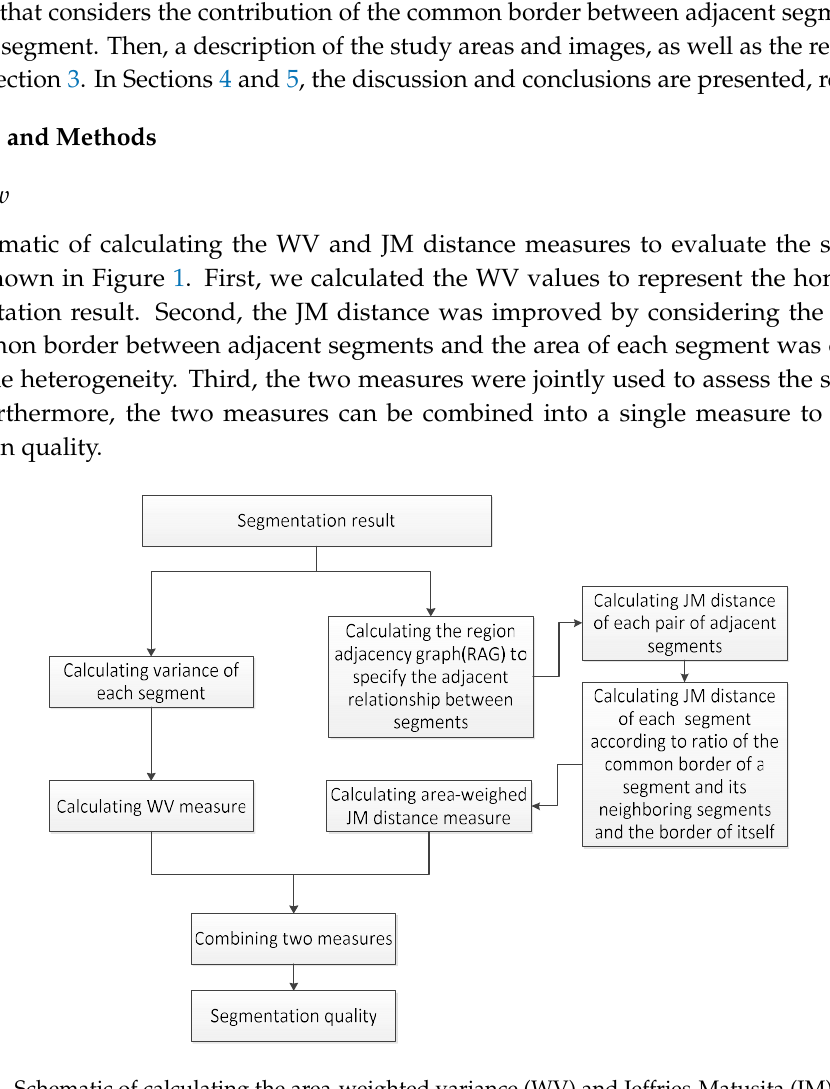
Figure 1. Schematic of calculating the area-weighted variance (WV) and Jeffries-Matusita (JM) distance measures to evaluate the segmentation quality.